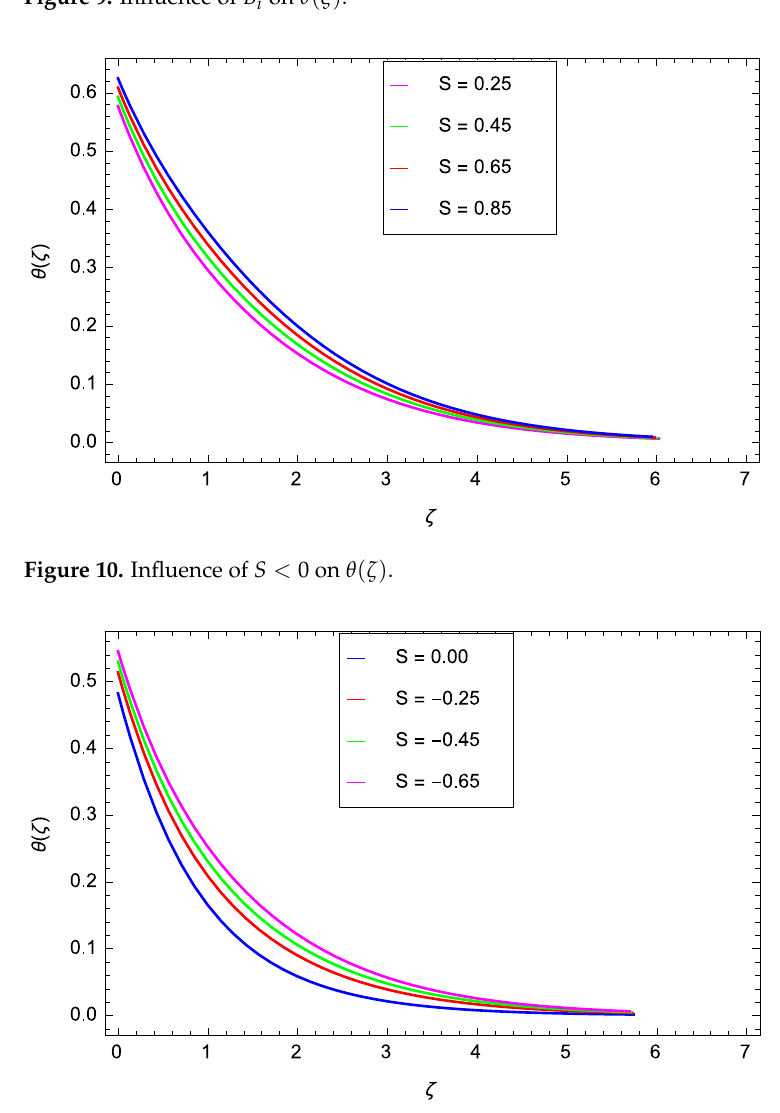
Figure 11. Influence of S > 0 on θ ( ζ )